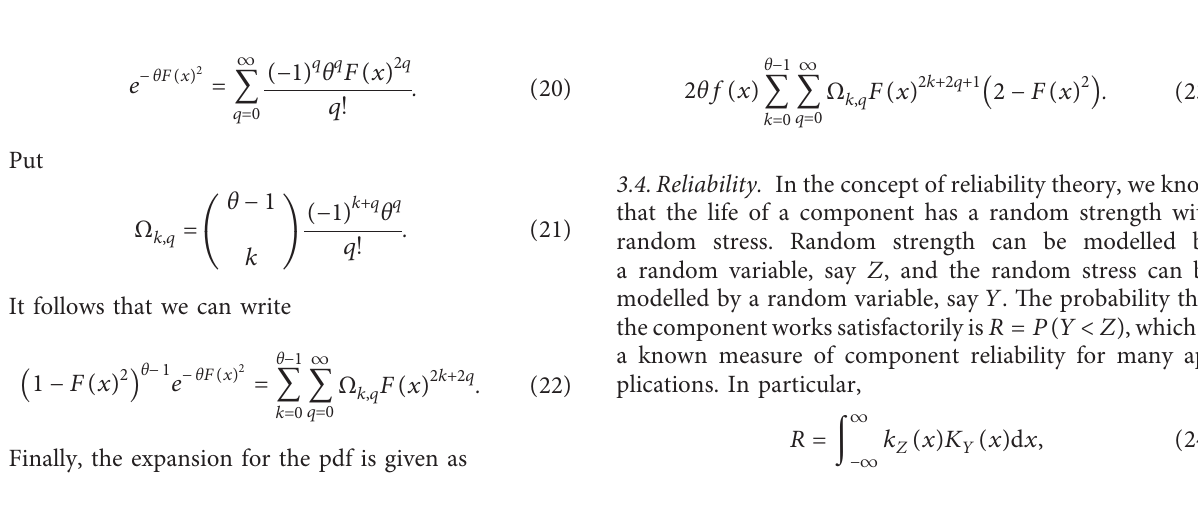
Figure 4: Plots for the skewness and kurtosis of the NGE-Weibull